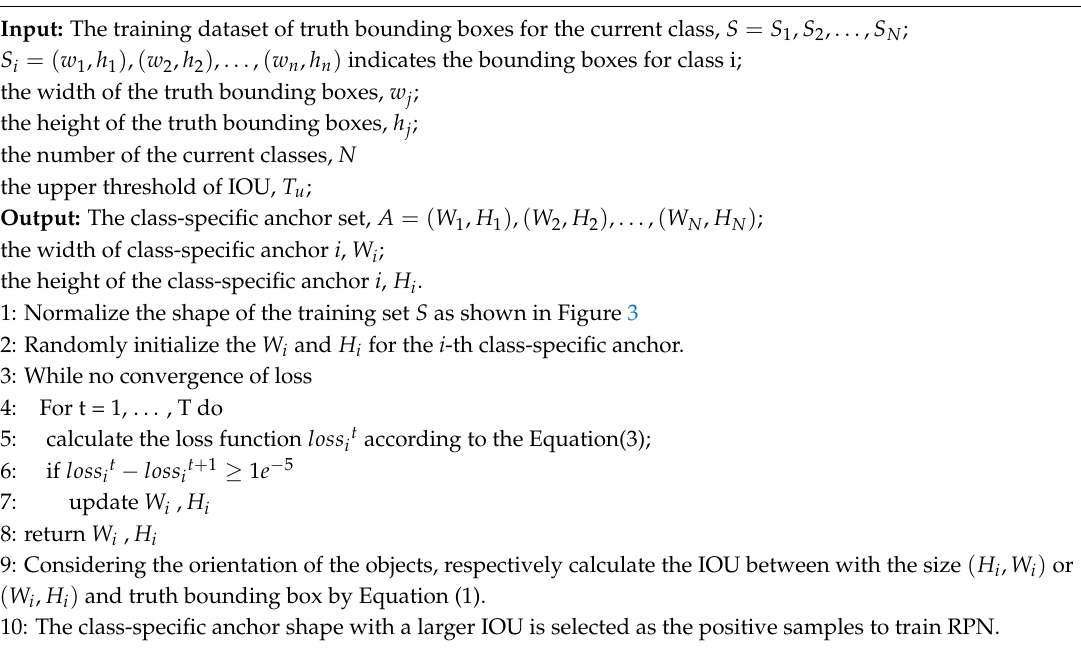
Algorithm 1. The procedure of the class-specific anchor based region proposal